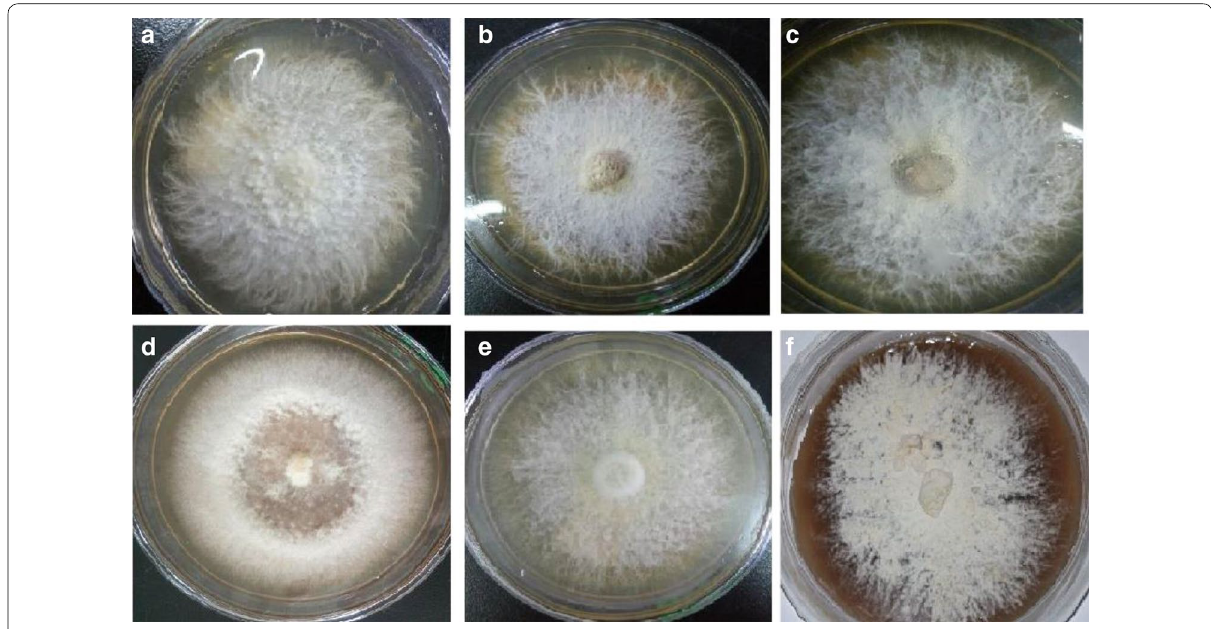
Fig. 1 The morphological characteristics of H. erinaceus dikaryotic mycelium on PDA medium. a H. erinaceus HT-4903, b H. erinaceus GT - 06 , c H. erinaceus CC-02, d H. erinaceus PZH-05, e H. erinaceus TJH-03, f H. erinaceus